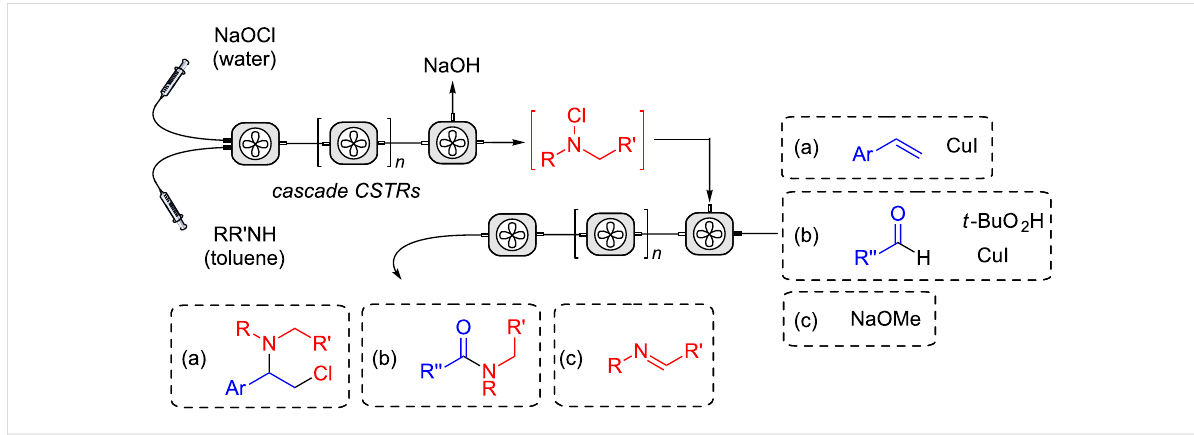
Figure 1: Continuous-flow process to produce and react N -chloramines.